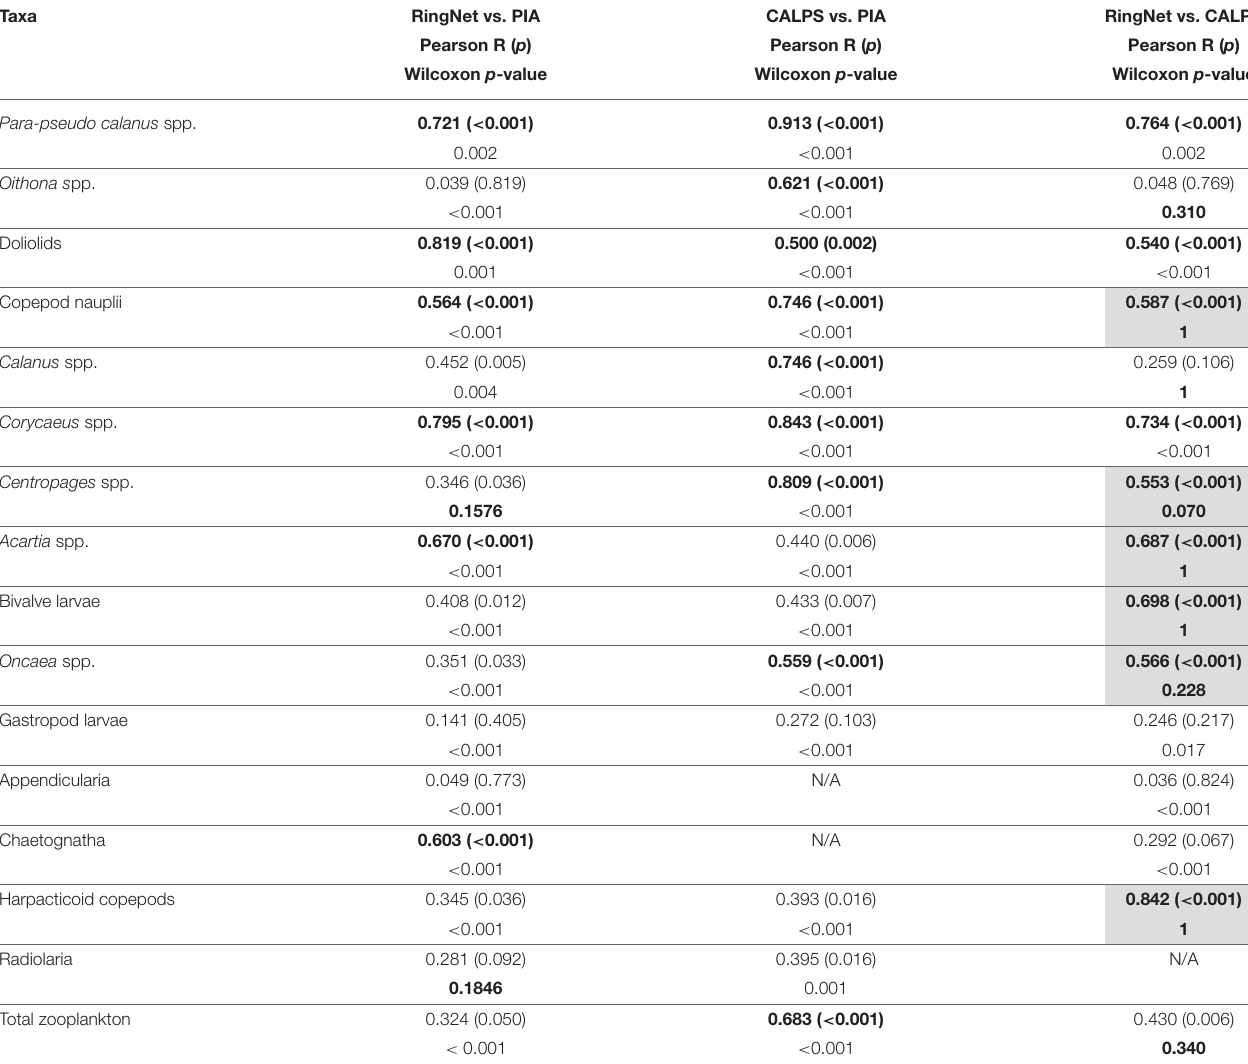
TABLE 3 | Relationships between the abundances of the main zooplankton taxa collected from the PIA, CALPS, and ring net devices. Taxa RingNet vs. PIA CALPS vs. PIA RingNet vs. CALPS Pearson R ( p ) Pearson R ( p ) Pearson R ( p ) Wilcoxon p -value Wilcoxon p -value Wilcoxon p -value Para-pseudo calanus